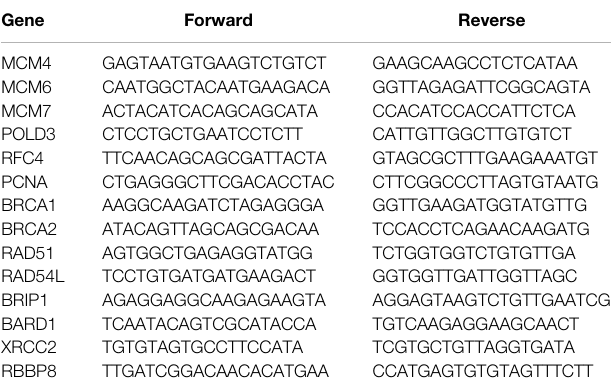
TABLE 1 | The primer sequences of DNA replication and HR genes used for qRT-PCR.